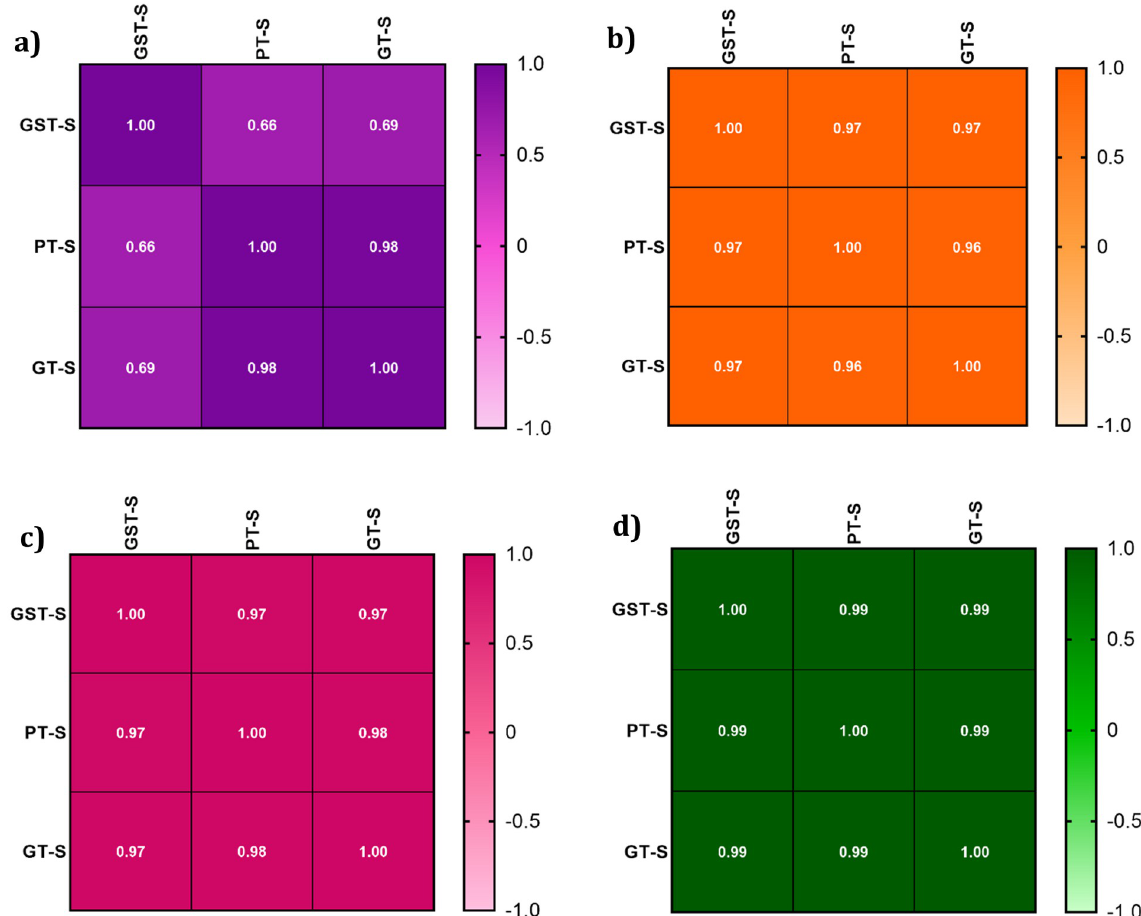
Fig 5. Pearson correlation coefficient (r) values of correlation analysis for the antioxidant parameters obtained with PT, GST and GT tubes. (a) total Thiol, (b) NO, (c) MDA, and (d) FRAP.